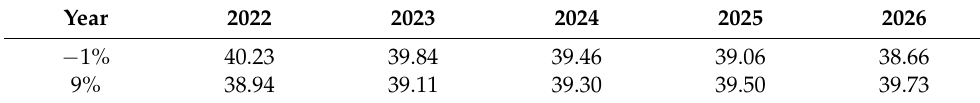
Table 10. Prediction results of water requirement with different growth rates of AVTI in Beijing.